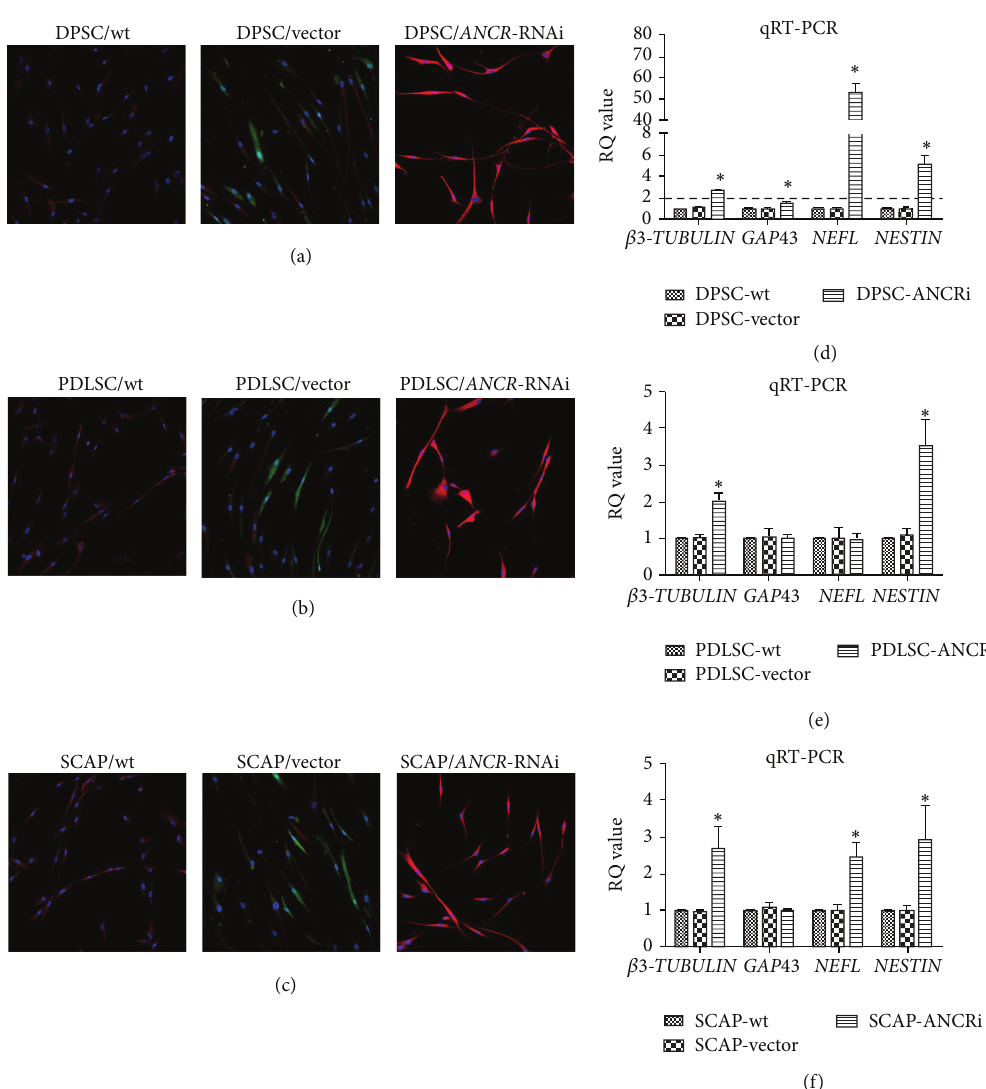
Figure 5: The effect of ANCR -RNAi on neurogenic differentiation in DTSCs. Immunofluorescence results showed that the expression of 𝛽 III-TUBULIN on DPSC/ ANCR -RNAi (a), PDLSC/ ANCR -RNAi (b), and SCAP/ ANCR -RNAi (c) cells was stronger than control groups. The green is the color of GFP (Green Fluorescent Protein) transfected by the vector. The red is the color of 𝛽 III-TUBULIN stained by DyLight 405. The morphology of DPSC/ ANCR -RNAi and PDLSC/ ANCR -RNAi cells was remarkably changed. The mRNA expressions of 𝛽 III-TUBULIN , GAP43 , NEFL, and NESTIN were upregulated in DPSC/ ANCR -RNAi cells (d) after 2 weeks of induction. In PDLSC/ ANCR -RNAi cells (e), 𝛽 III-TUBULIN and NESTIN were upregulated, while GAP43 and NEFL had little change compared with control groups. In SCAP/ ANCR - RNAi cells (f), 𝛽 III-TUBULIN , NEFL , and NESTIN were upregulated while GAP43 had little change compared with control groups. ∗ 𝑃 < 0.05 when compared with the control